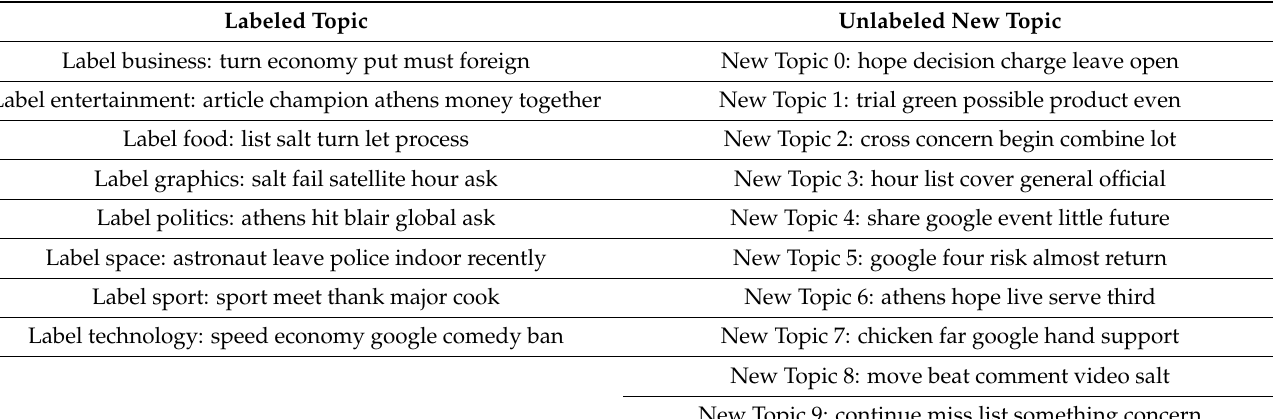
Table 5. PLDA results for 10 Newsgroups dataset.